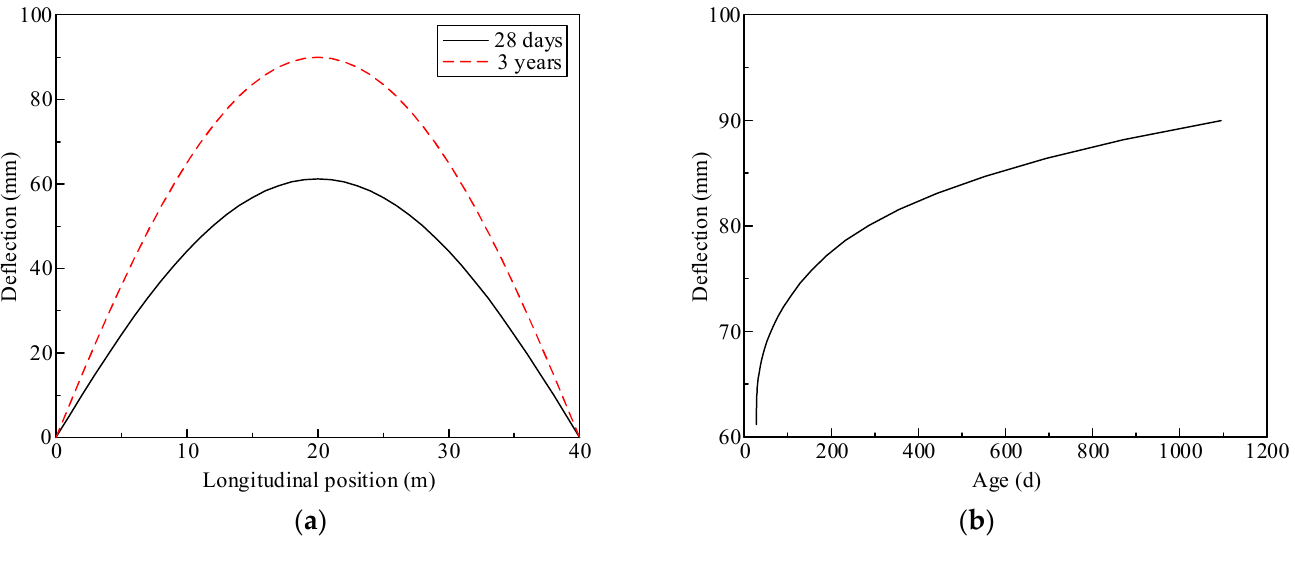
Figure 13. Deflection of the composite beam (time-dependent analysis). ( a ) Distribution along span; ( b ) Change with time at mid-span section.